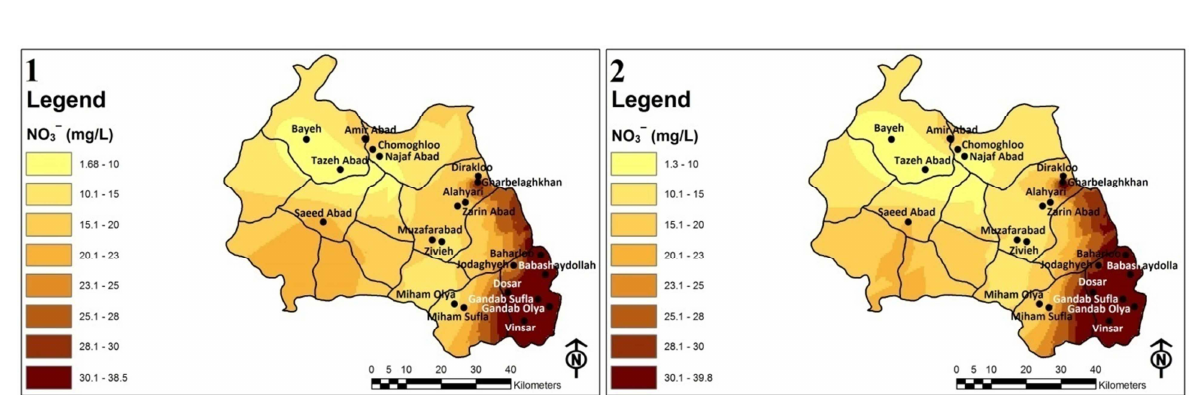
Figure 1. Spatial distribution of nitrate in ground water in low- and high-water seasons Table 5. Trace metal concentrations (µg/l) in drinking water samples (high-water season)